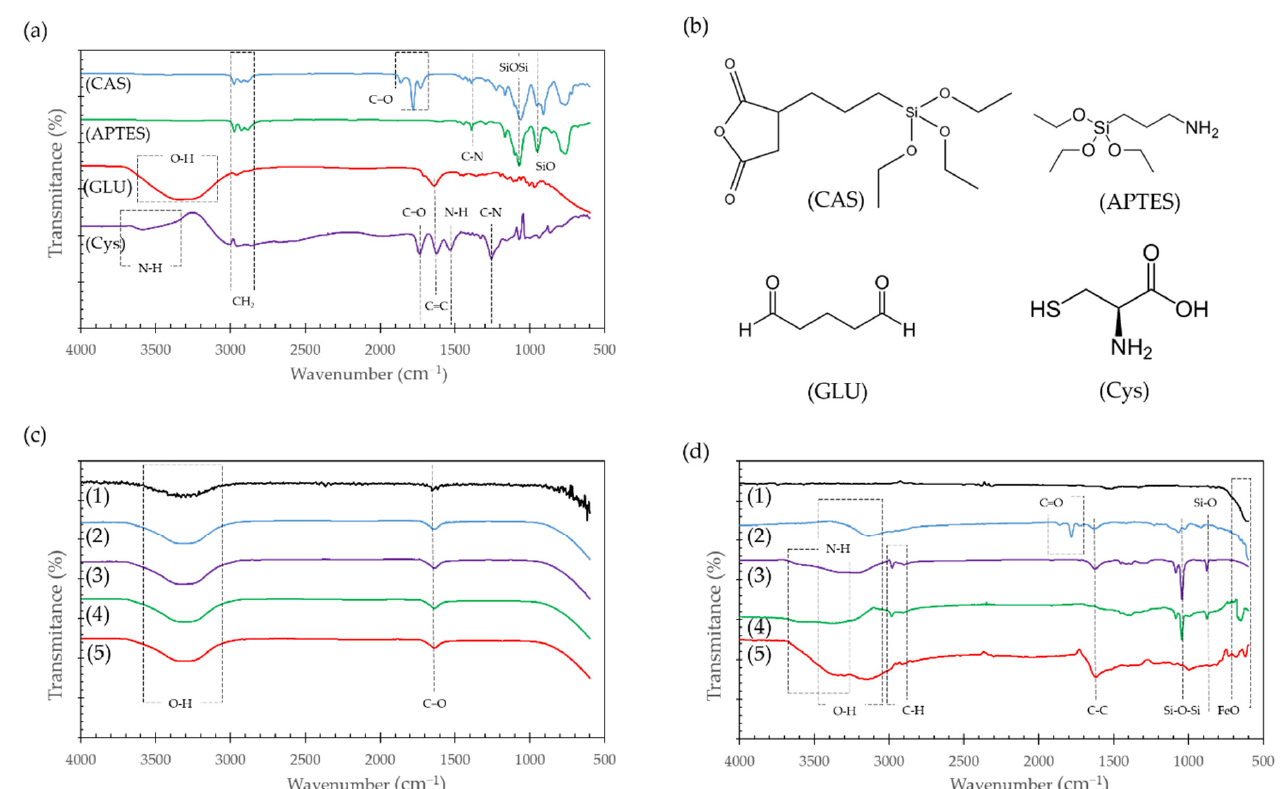
Figure 4. FTIR spectra ( a ) and chemical structure ( b ) of pure CAS, APTES, GLU and Cys. Additionally, FTIR spectra of ( c ) Al 2 O 3 spheres and ( d ) Fe 3 O 4 NPs. Each one functionalized with (2) CAS, (3) CASCys, (4) APTES and (5) APTES@GLU@Cys. The spectra of bare adsorbents were added for comparison (1).